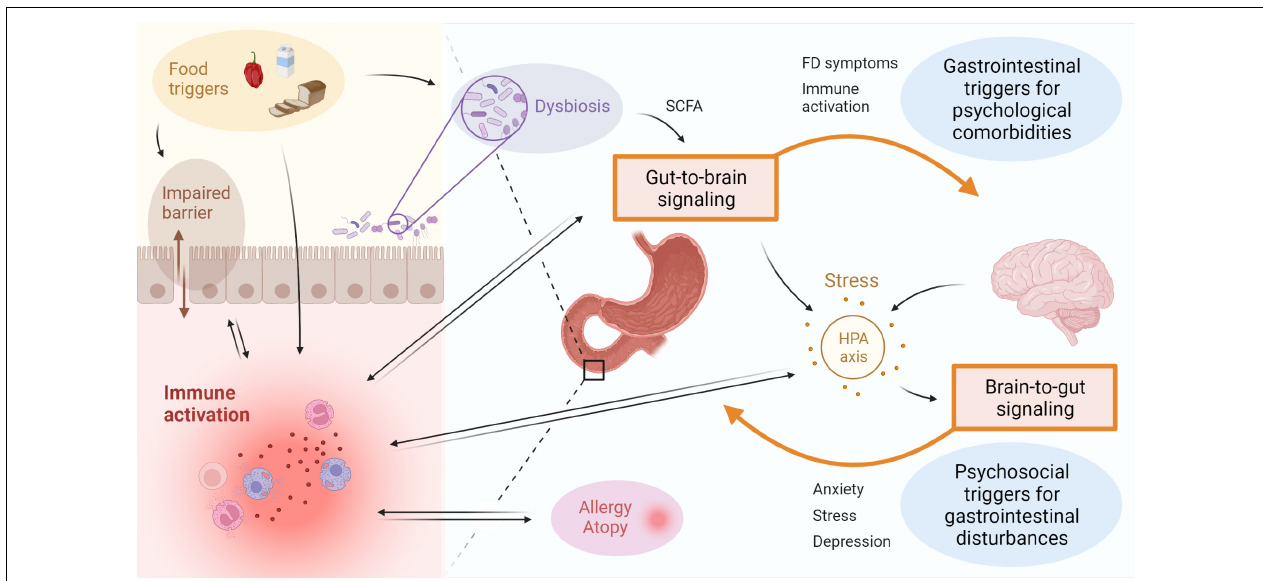
FIGURE 2 | Immune activation is linked to disturbances of the gut-brain-axis in FD. Bidirectional interaction between the gut and the brain involves GI symptoms and immune activation as potential triggers for psychological comorbidities, as well as psychosocial factors including stress, anxiety or depression resulting in gastroduodenal alterations. Activation of the HPA axis is suggested to play an important role, with both central and gut-derived mediators directly leading to induction of stress, which in turn can trigger GI symptoms. Factors associated to the intestinal inflammatory environment include microbial alterations and barrier impairments, both of which can be a cause or consequence of immune activation. The gut microbiota is also suggested to influence gut-to-brain communication directly or indirectly via metabolites such as SCFA. Food triggers are a major determinant of the microbiota composition and can also directly induce immune activation and impact barrier function. A relation between duodenal immune activation and allergy or atopy is proposed, but directionality and causality need to be established. FD: functional dyspepsia, GI: gastrointestinal, HPA: hypothalamic-pituitary-adrenal, SCFA: short-chain fatty acids. This figure was created in